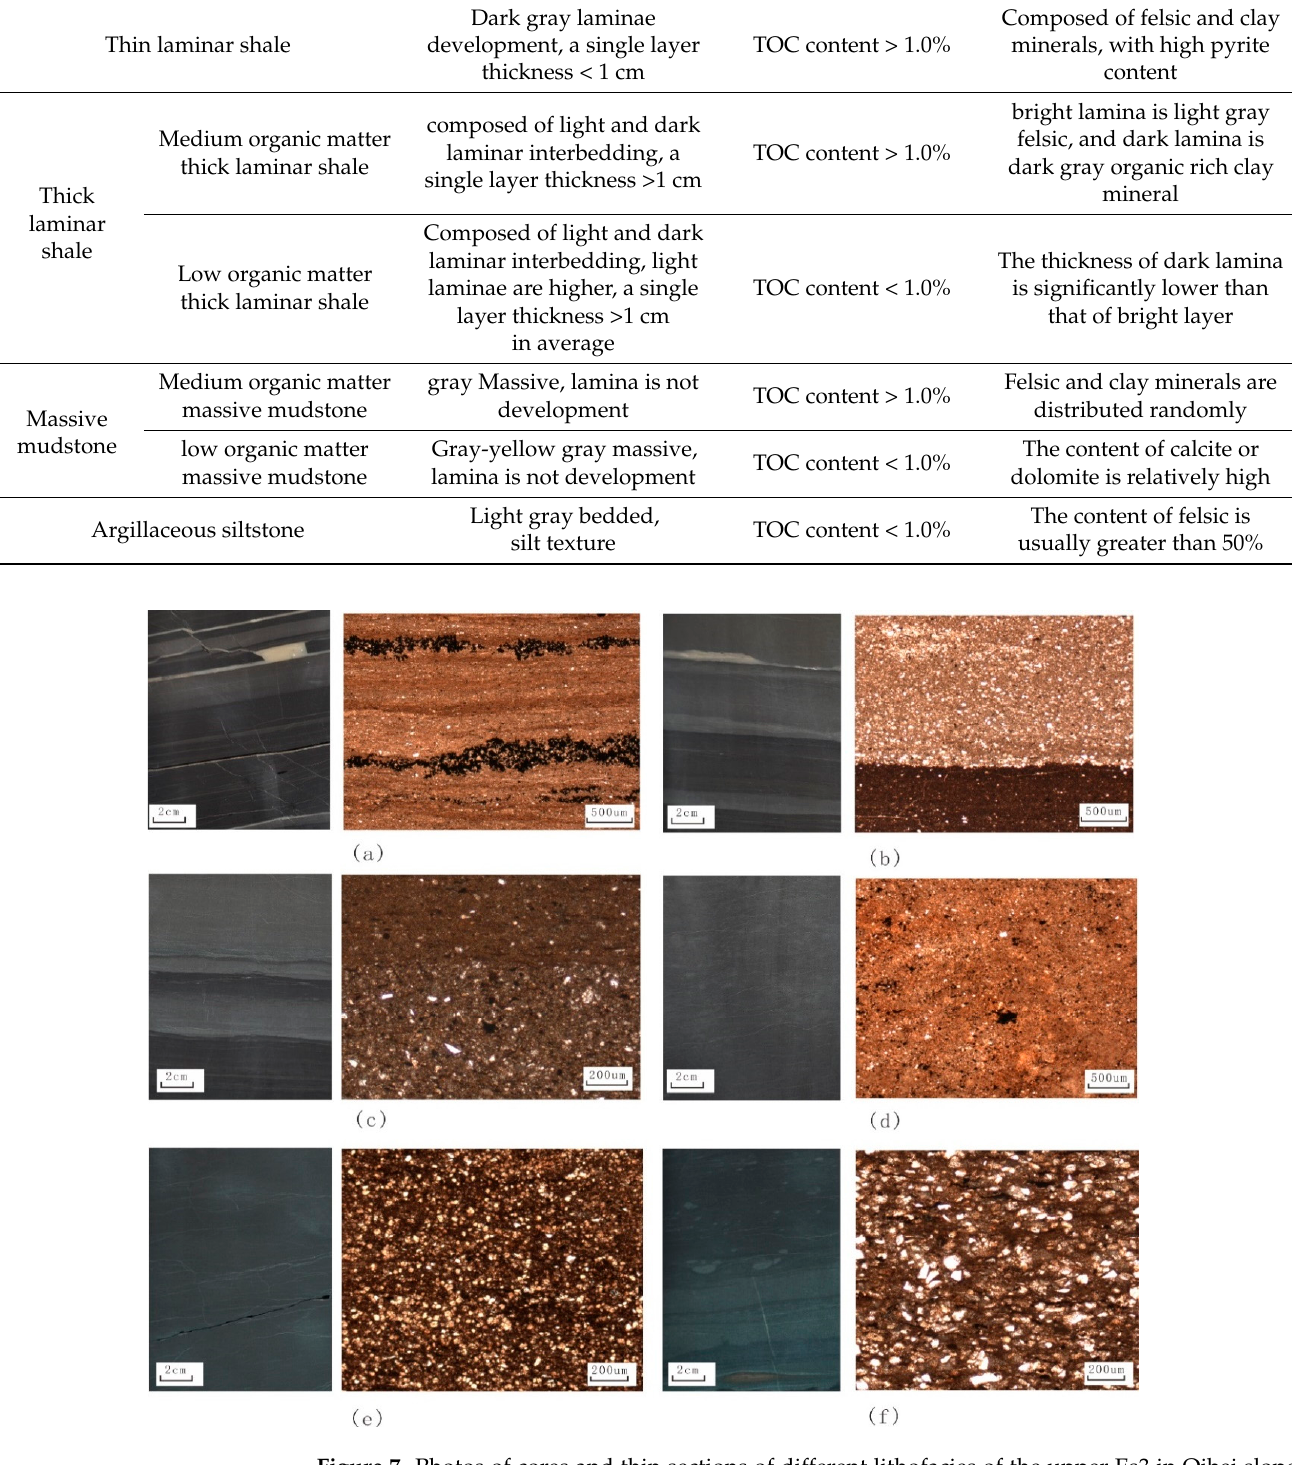
Figure 7. Photos of cores and thin sections of different lithofacies of the upper Es3 in Qibei slope. ( a ) Thin laminar shale, 3993.28 m; ( b ) medium organic matter thick laminar shale, 4377.2 m; ( c ) low organic matter thick laminar shale 3997.9 m; ( d ) medium organic matter massive mudstone, 3989.7 m; ( e ) low organic matter massive mudstone, 4381.1 m; ( f ) argillaceous siltstone, 3892.5 m . Table 2. statistical table of shale facies mineral composition and organic matter content in Es3 mem- ber (unit: mass fraction%).